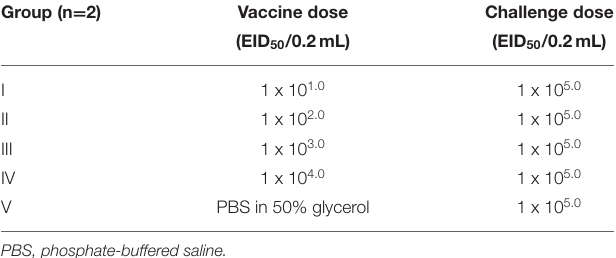
TABLE 1 | Vaccine immunizing dose and protective efficacy analysis. Group (n = 2) Vaccine dose